Question: According to the figure, is the described quantity increasing or decreasing?
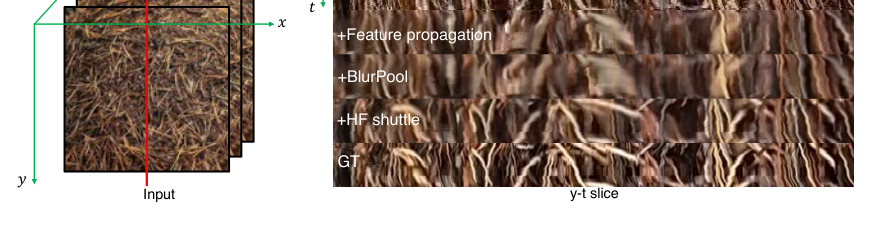
Answer: increasing